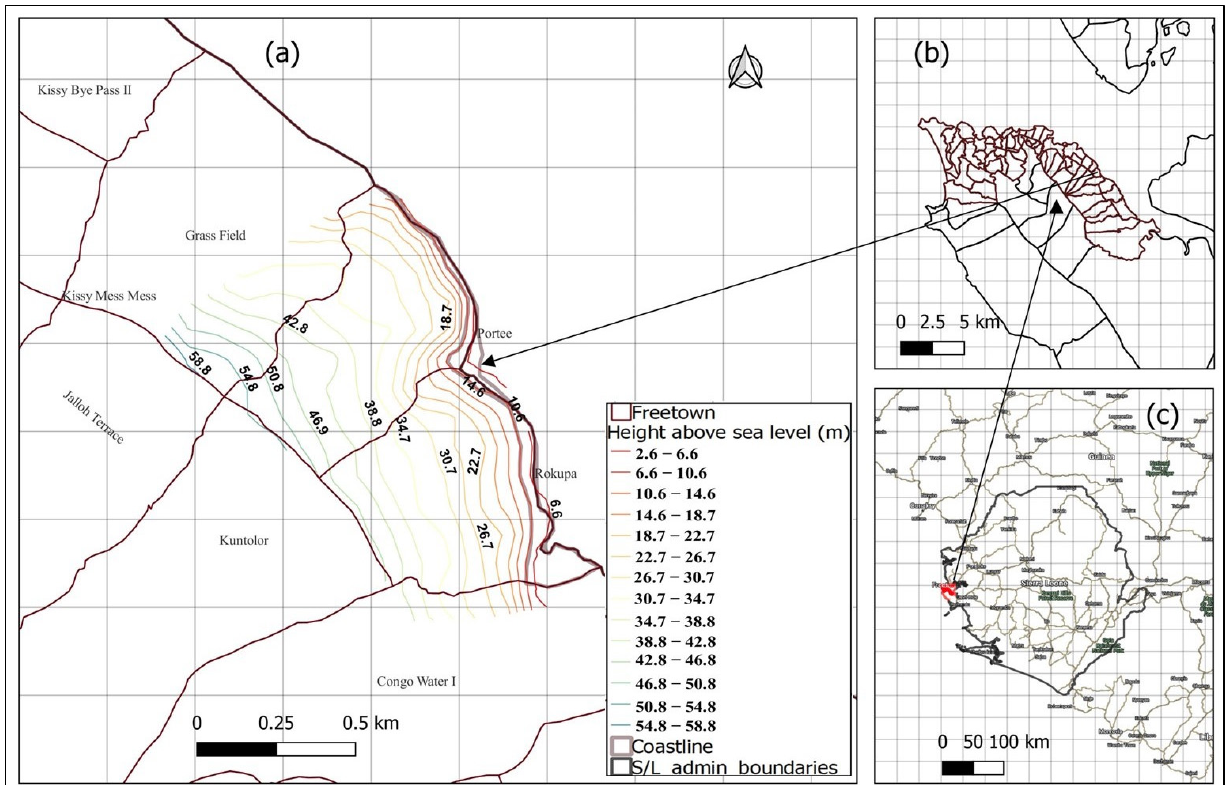
Figure 1. Overview of Portee and Rokupa ( a ); Freetown City ( b ); and Sierra Leone ( c ). Shapefiles, https://data.humdata.org/dataset/cod-ab-sle; elevation: Google Earth Pro; labels in 1c, Google Labels. Accessed on 21 October 2022. Drawn: Author.